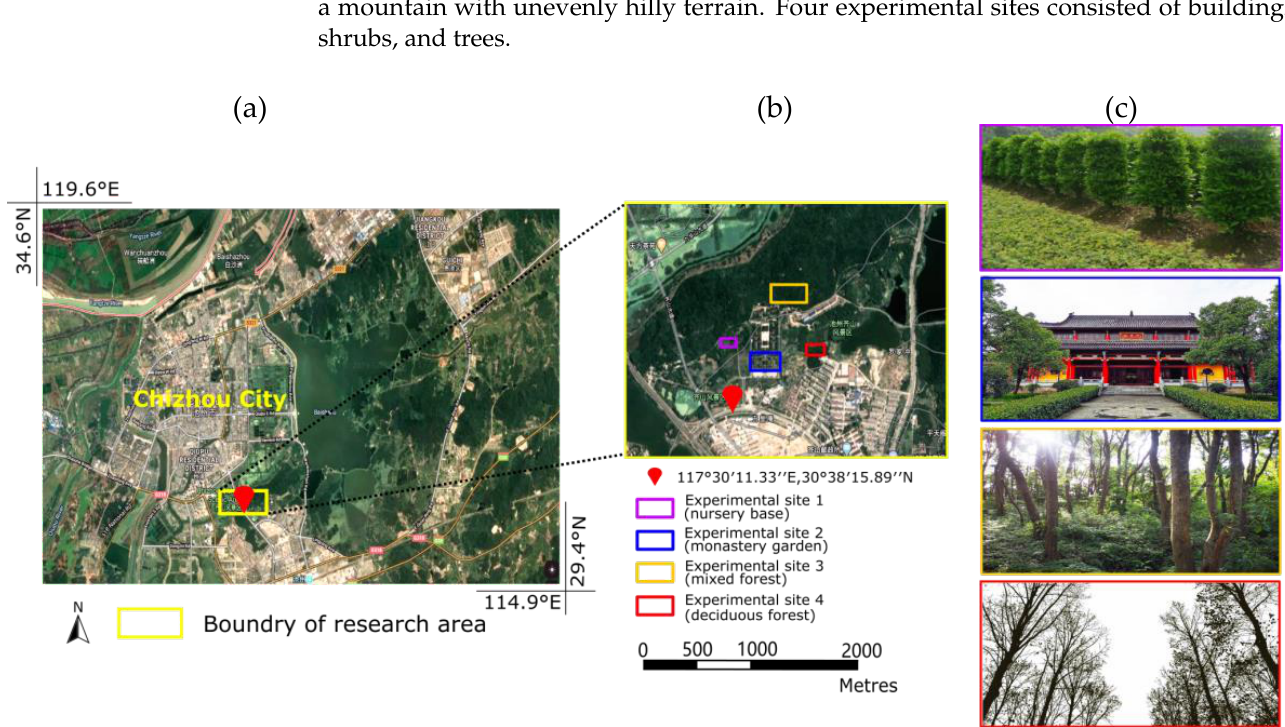
Figure 2. General situations of the study area. ( a ): The location of the study area and the four experimental sites within the Qishan scenic area, Chizhou, Anhui province, China. ( b ): The remote sensing image acquired from Google Earth, where the different coloured rectangles mark the edges of the different experimental sites. ( c ): The photos show the growth of trees in the four experimental sites.